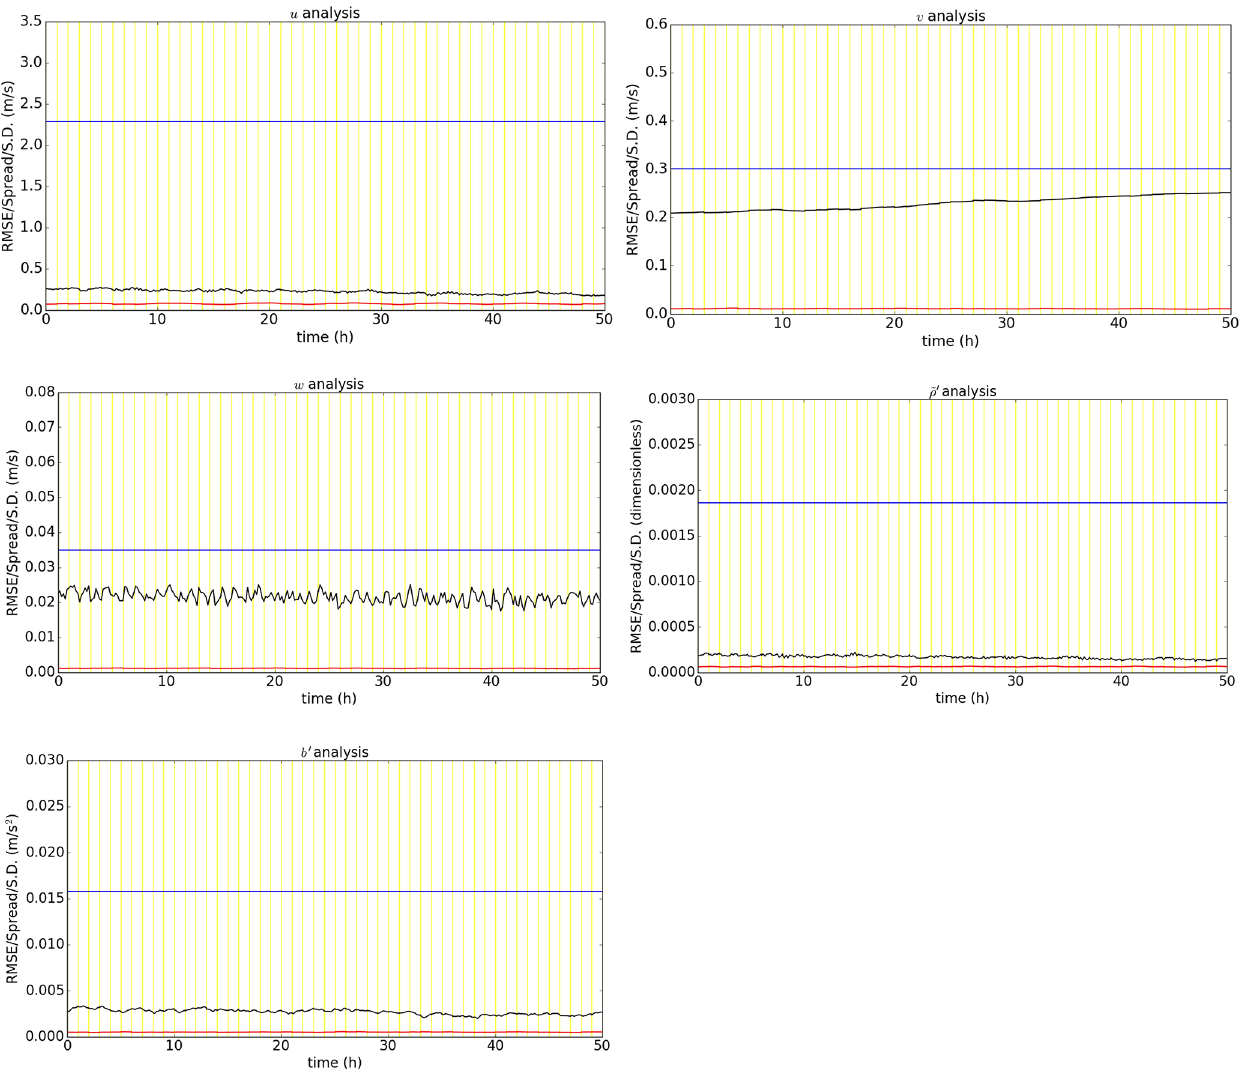
Figure 7. Time series of root mean square analysis errors (black) and ensemble spread (red) for the EBV(d) (100% B e ) ensemble, computed over a subset of the domain (a box located at the centre of the domain, model levels 25 to 35, longitudinal grid points 127 to 237). The implied (time-stationary) background error standard deviation at model level 30 is also included